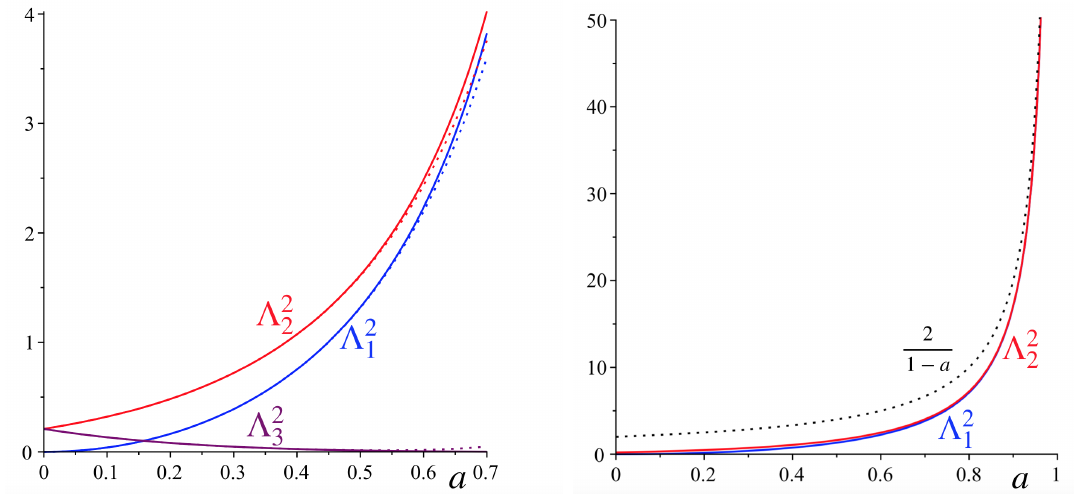
Figure 2 . The metric functions Λ 2